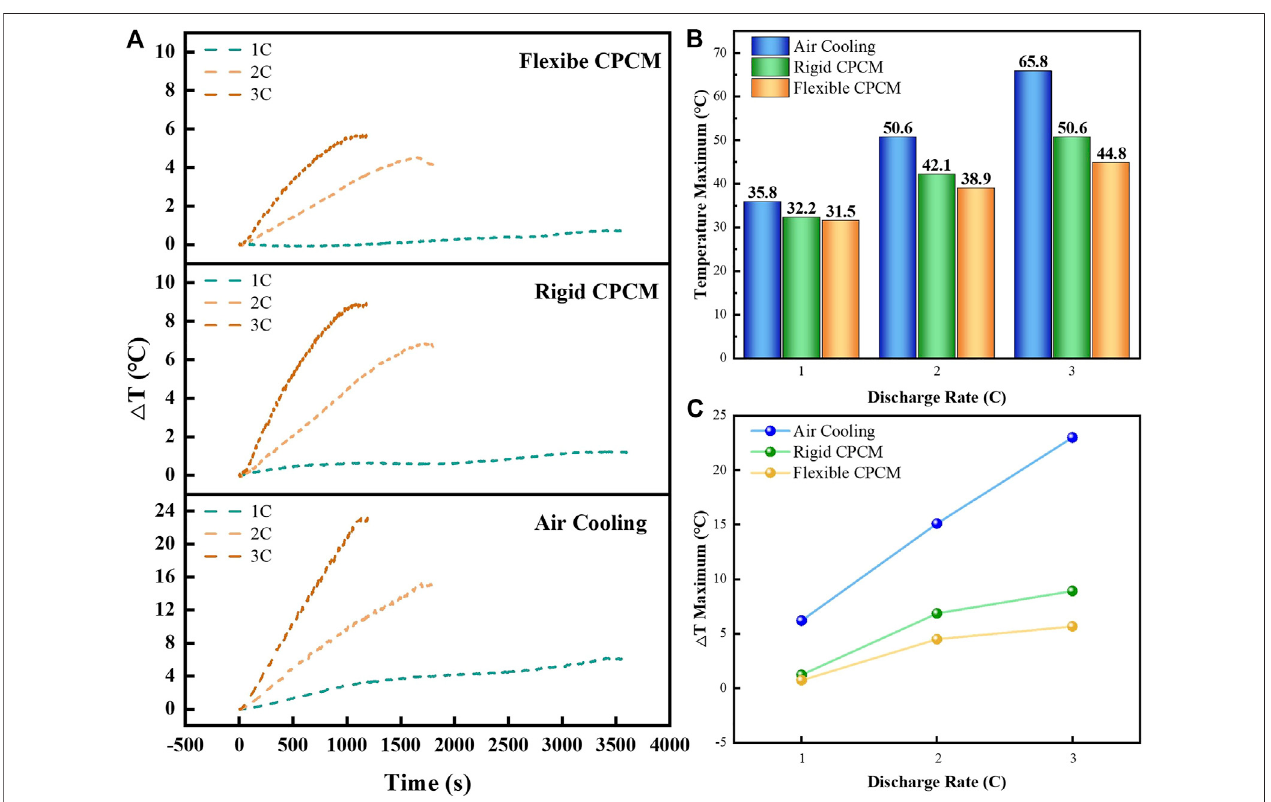
FIGURE 8 | (A) Temperature difference curves during the discharge process of the three battery modules with different cooling methods. (B) Maximum temperature values during discharge of the battery modules with three different cooling methods. (C) Maximum temperature difference values during discharge of the battery modules with three different cooling